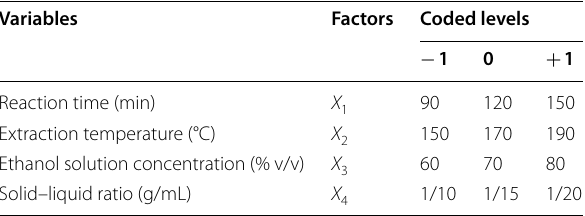
Table 1 Horizontal coding table of the influencing factors in the Box–Behnken design